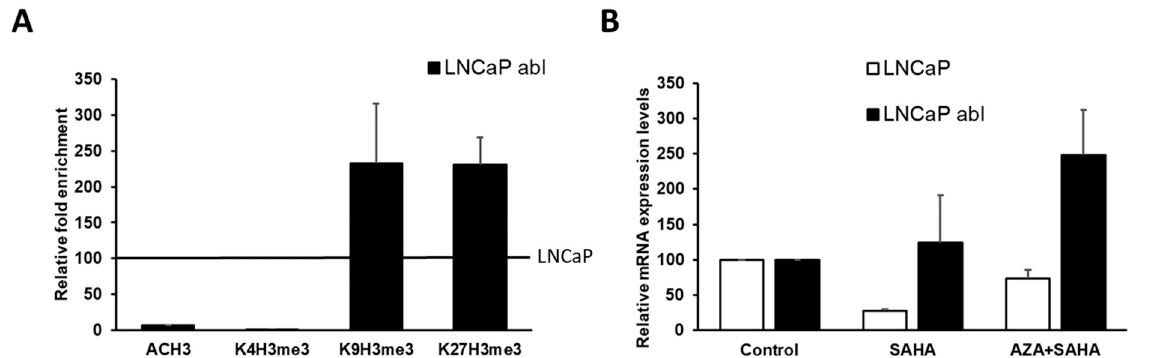
Figure 4. ( A ) Chromatin immunoprecipitation analyses for histone H3 acetylation (AcH3) and the methylation of lys4 (K4H3me3), lys9 (K9H3me3), and lys27 (K27H3me3) of histone H3 of CLDN3 in prostate cancer cell line. The graph shows the enrichment of CLDN3 promoter DNA measured by real-time PCR. Data shown represent the mean ± s.e.m. of two independent experiments. ( B ) QRT- PCR showing mRNA expression levels of CLDN3 in prostate cancer cell lines treated with 5 µ M SAHA or 2 µ M AZA plus 5 µ M SAHA. Data shown represent the mean ± s.e.m. of three independent experiments completed in triplicate.